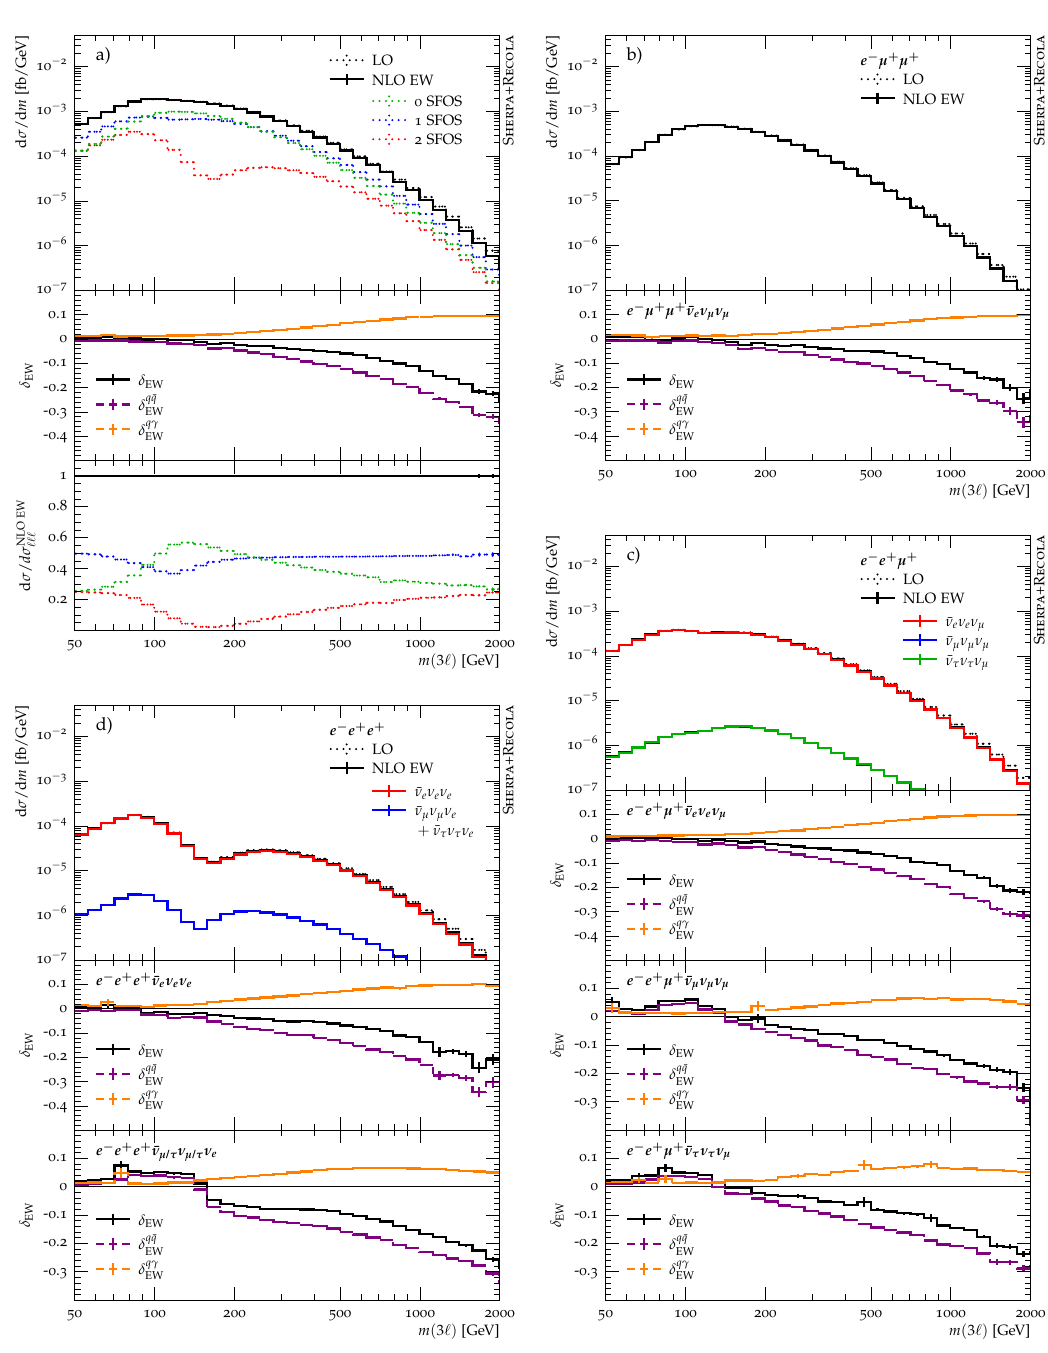
Figure 1 . Electroweak corrections to the trilepton invariant mass distribution.